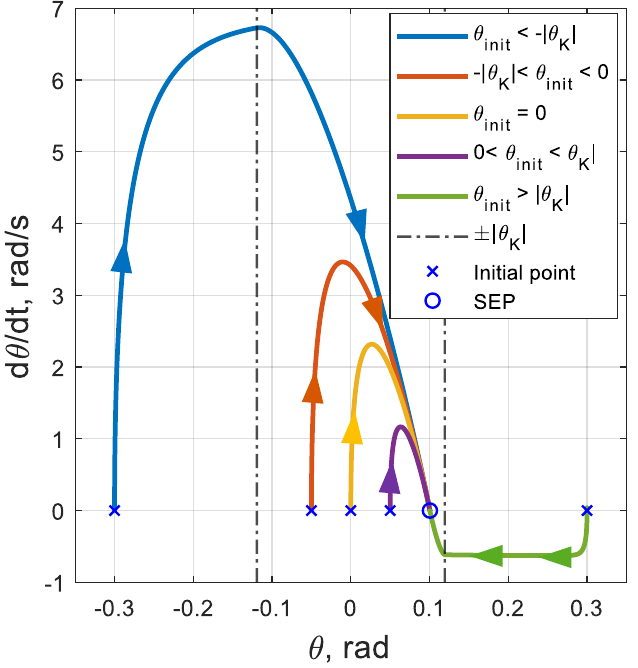
Figure 9. Phase portrait of different initial phases of P-f loop at post-fault period. In addition, in Figure 1, the active power output from B1 (power semiconductors circuit) to B2 (terminal port) is cos ( θ Zf ) − cos ( θ init − θ U + θ Zf ) p ( θ init ) =